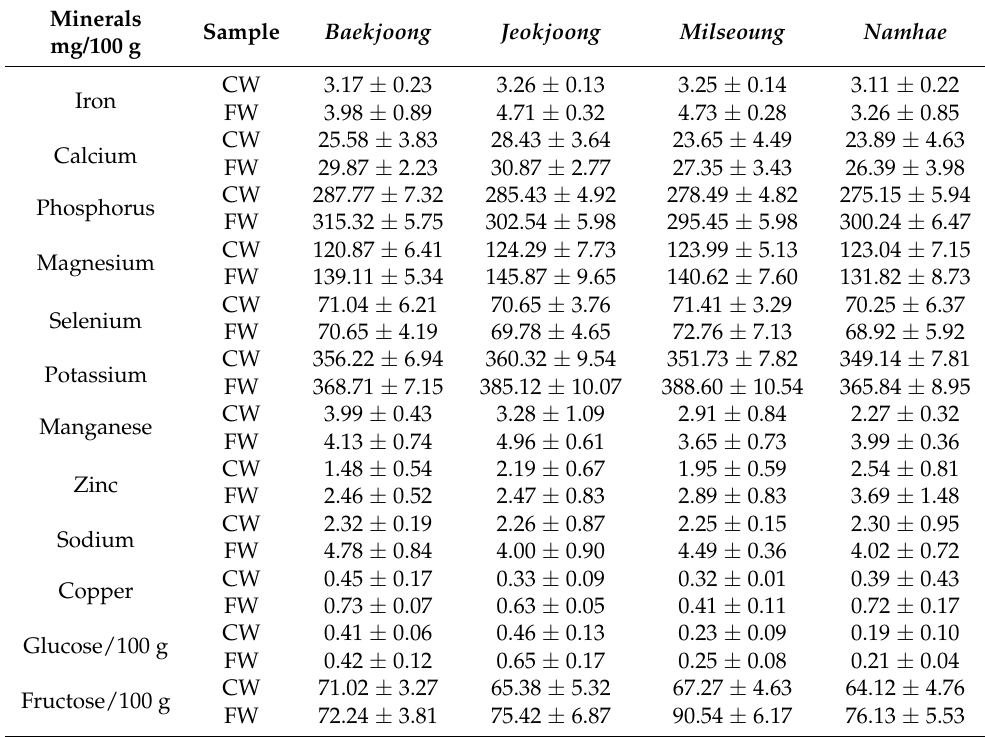
Table 2. Minerals and carbohydrate contents of cooked and fermented